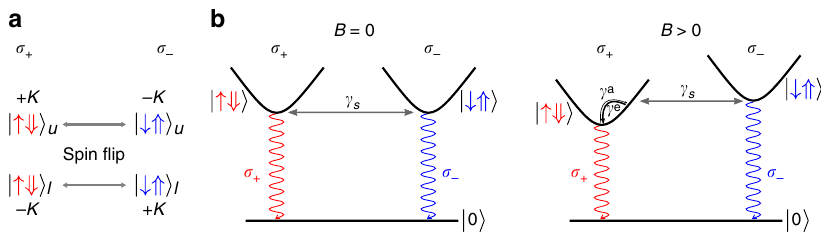
Fig. 4 Origin for PL polarization in bilayer. a The requirement for the switching of light helicity can be thought of as interconversion between circularly polarized excitons, σ ex þ and σ ex (cid:2) . The emission helicity is tied to the spin of the electron in the exciton, which is formed out of electron – hole pairs in both valleys/layers. The hole spin is labeled by thick vertical arrows and in our convention have spin, which is opposite to that of the electron. Owing to spin – valley-layer locking, both spin and valley need to be fl ipped for the switching of helicity, in the absence of interlayer hopping. b At positive magnetic fi eld, the selective conversion of σ ex σ ex (cid:2) to þ is energetically favorable due to the